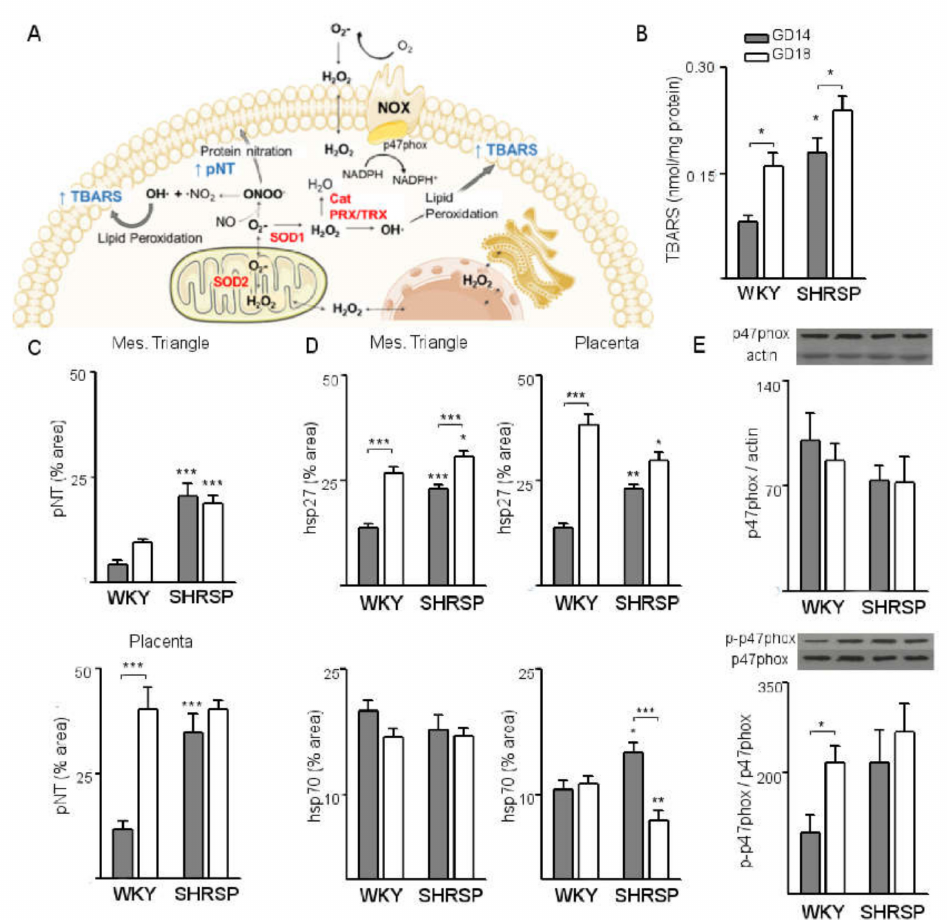
Figure 2. Sustained activation of placental CSR pathways in SHRSP pregnancies. ( A ) Schematic diagram summarizing the CSR and antioxidant defense pathways investigated in this study. NADPH oxidase (NOX) activation or increased activity of the mitochondrial electron flux leads to accumu- lation of superoxide (O 2 •− ), which under normal conditions is rapidly dismutated to hydrogen peroxide (H 2 O 2 ) by superoxide dismutases (SOD1, SOD2). H 2 O 2 can readily diffuse through mem- branes to react with proteins and DNA and is detoxified by cellular peroxidases (catalase (Cat) and the peroxiredoxin/thioredoxin systems (PRX/TRX)). Failed detoxification of ROS produces peroxynitrite (ONOO − ) and hydroxyl radicals (OH • ), promoting the nitration of membrane proteins and the lipid peroxidation cascade. ( B ) Analysis of lipid peroxidation in both pregnancy models as assessed by quantification of placental TBARS. ( C ) Analysis of protein nitrotyrosine (pNT) levels in maternal (mesometrial triangle, top panel) and trophoblastic (placenta, bottom panel) layers of WKY and SHRSP implantations as analyzed by immunohistochemistry. ( D ) Immunohistochemical analyses of the expression of CSR chaperones hsp27 (upper panels) and hsp70 (bottom panels) in both models. ( E ) Evaluation of placental NOX activation in both pregnancy models as indicated by Western blot analyses of total and phosphorylated p47phox levels. The results are expressed as the means ± SEM, n = 5–7 animals/group. In all the panels, * p < 0.05, ** p < 0.01 and *** p < 0.001 as evaluated by two-way ANOVA and Bonferroni post-hoc